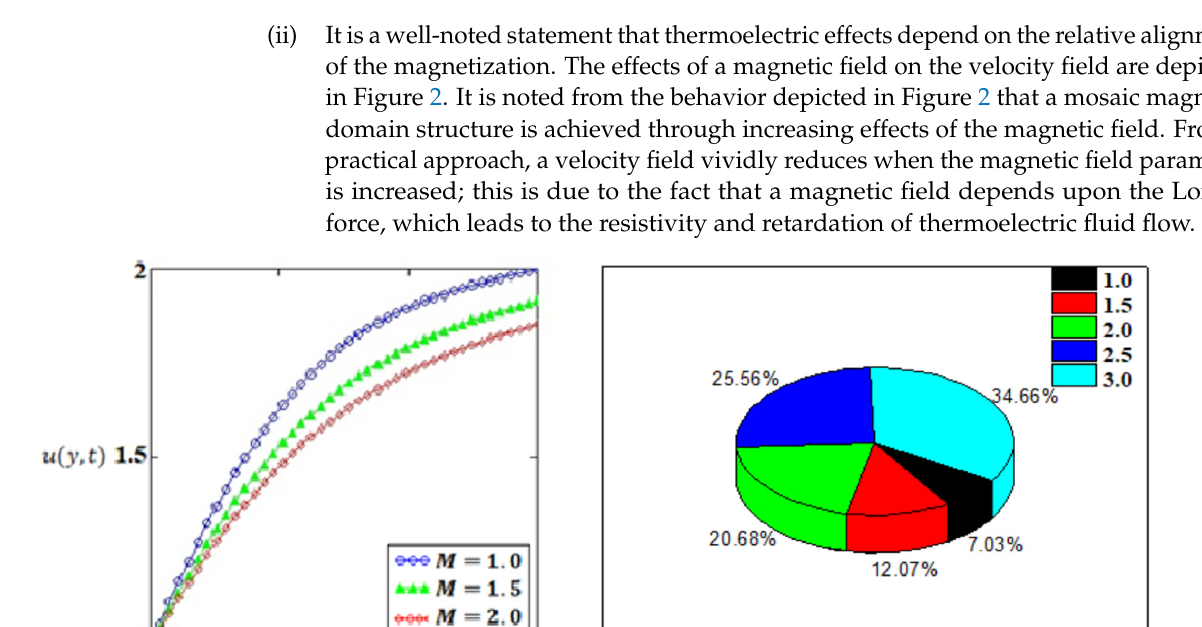
Figure 2. Graphical illustration of fractional approach of Caputo-Fabrizio with ℛ (cid:2868) = 1, 𝐾 (cid:2868) = 0.9, 𝑍𝑇 = 4.2, 𝜔 = 0.5, 𝑡 = 1, 𝛼 = 0.6, 𝑃𝑟 = 15 for different magnetic parameter val- (cid:2868) ues.